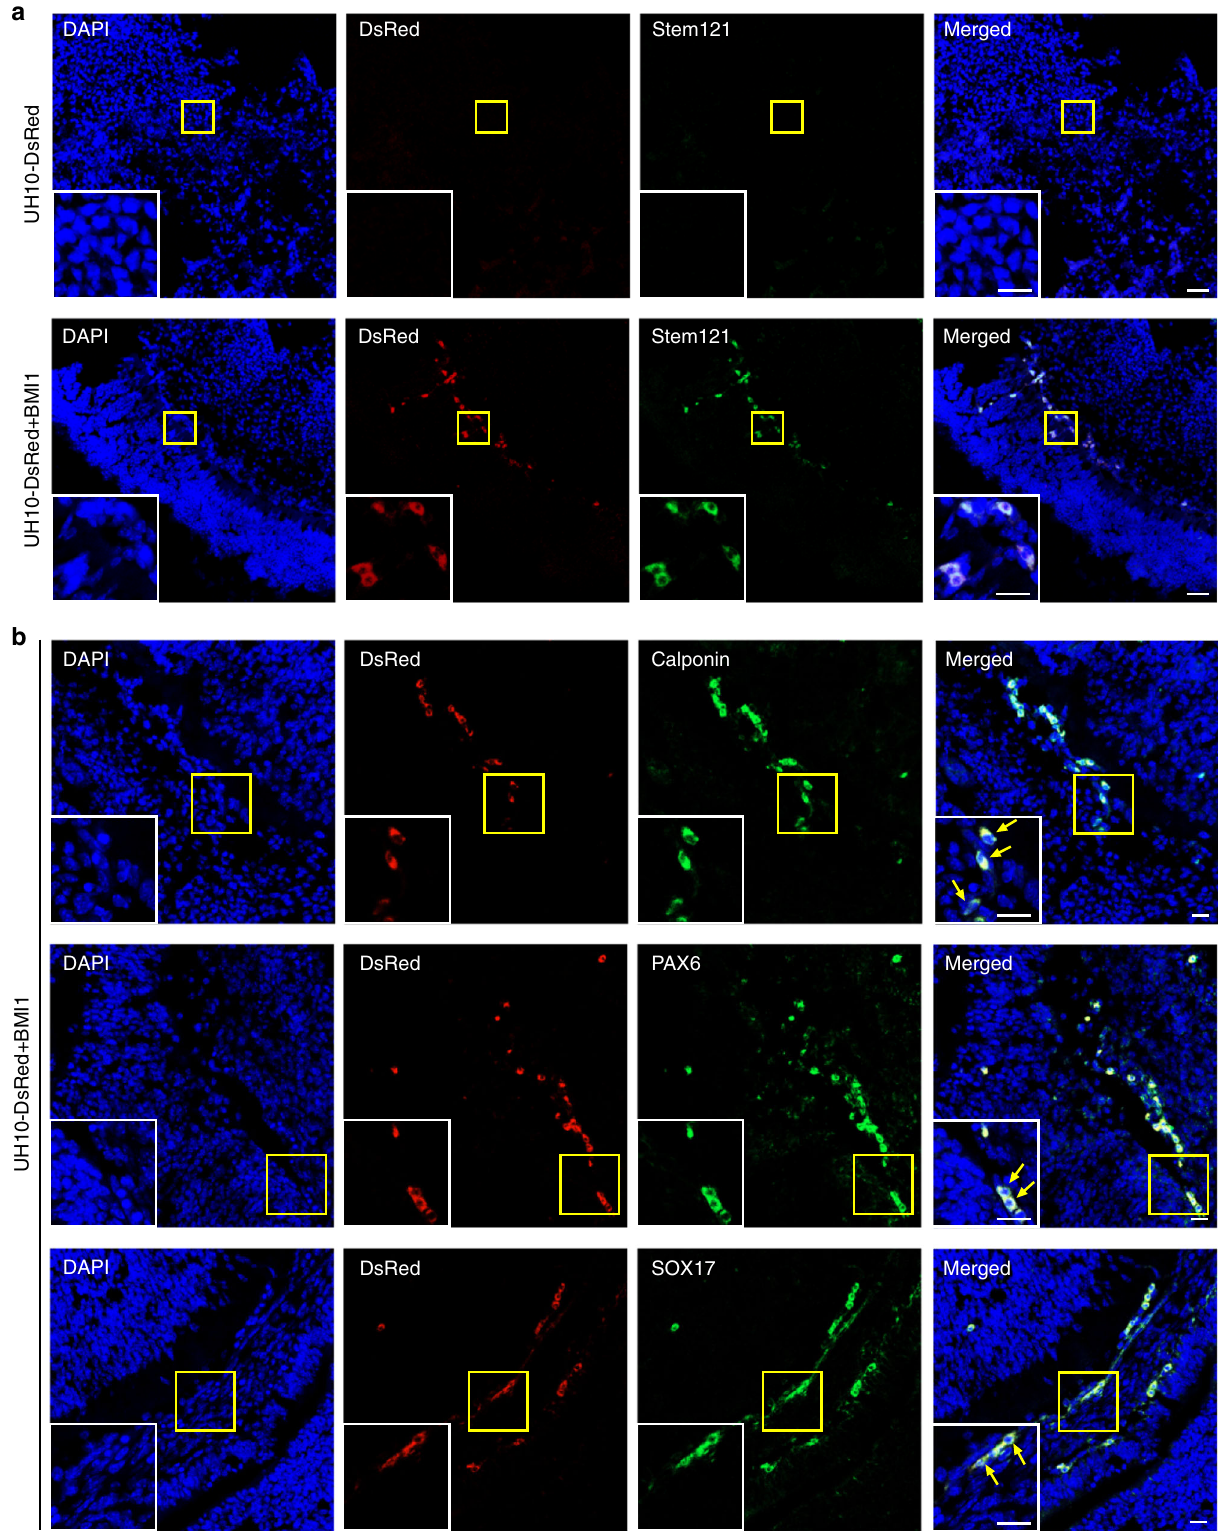
Fig. 2 Contribution of different lineage cells by hPSCs + BMI1. Sections of E10.5 mouse chimeric embryos were analyzed by immunostaining on selected markers. a Representative images showing the integrated DsRed + human cells coexpress human-speci fi c marker Stem121 in chimeric embryos. Scale bars, 20 µ m (left), 50 µ m (right). b DsRed + human cells in mouse chimeric embryo were costained with antibodies against Calponin, mesoderm marker, PAX6, ectoderm marker and SOX17, endoderm marker. The insets are the zoom-in pictures of the areas of yellow box. Scale bars, 20 µ m (left), 50 µ m (right)